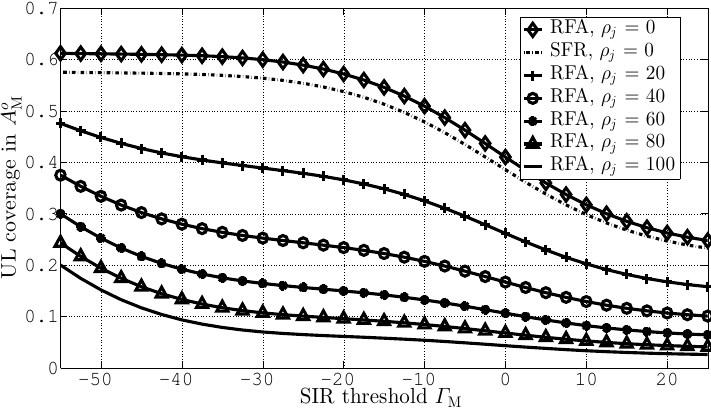
Figure 4. UL coverage against Γ M and ρ J in A o